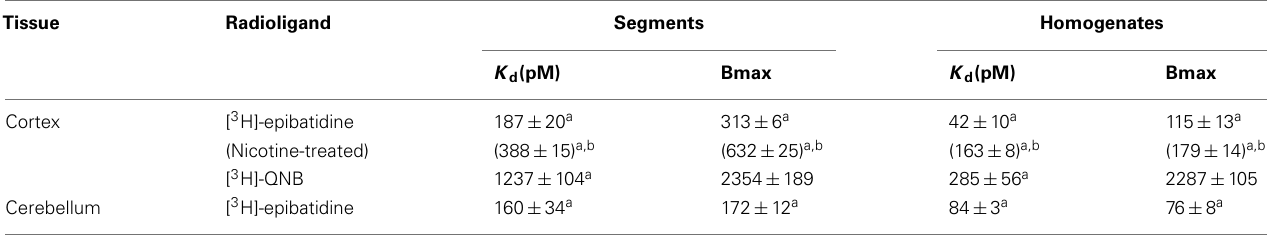
Table 1 | Binding parameters of [ 3 H]-epibatidine and [ 3 H]-QNB in rat cortex and cerebellum.